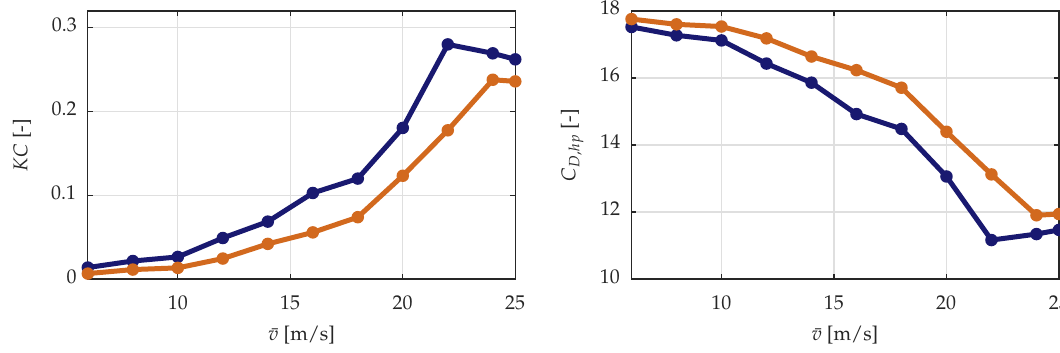
Figure 11. Heave plate KC -number and resulting quadratic drag coefficient C D , hp from data of Figure 8 for environmental conditions of Table 2. Case (1): Damping (blue) with Closed Loop (CL) system model iterated until convergence. Case (2): Excitation (orange) with body velocity calculated based on panel code RAO and wave kinematics with linear wave